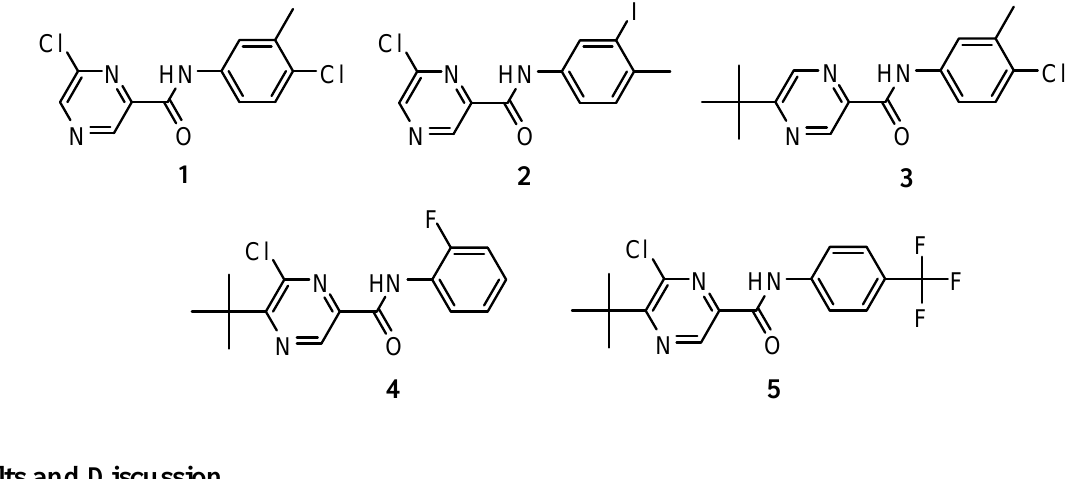
Figure 1. Novel pyrazinecarboxylic acid amides 1 - 5 designed and prepared for their herbicide and abiotic elicitation activity evaluation.